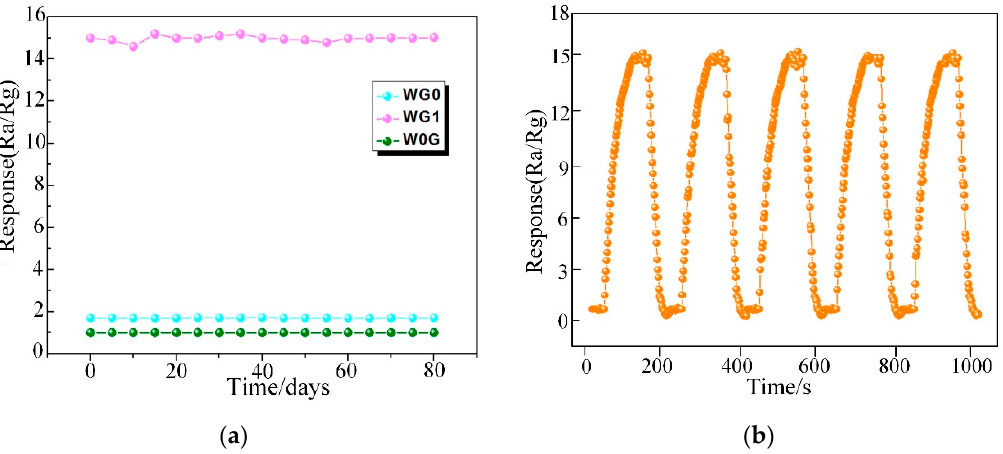
Figure 13. ( a ) The stability of W0G, WG0, and WG1 to 50 ppm C 2 H 2 gas at 150°C; and, ( b ) The repeatability of WG1 gas sensor to 50 ppm C 2 H 2 gas at 150°C. Table 1. Comparison between our work and other reported work on C 2 H 2 gas